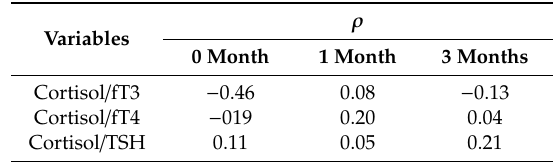
Table 1. Pearson’s correlation ( ρ ) between cortisol / fT3 ratio (B) cortisol / fT4 ratio (C) cortisol / TSH ratio. Pearson index was considered significant for values between +1 and − 1.